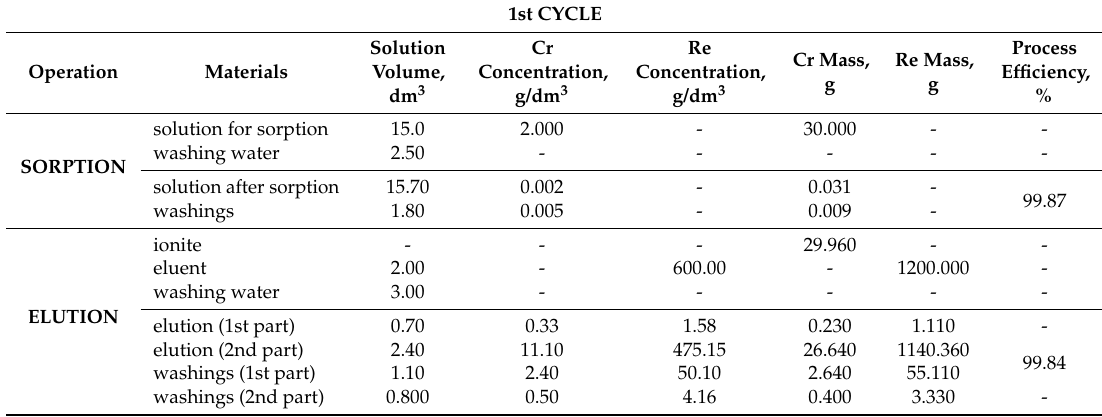
Table 1. Chromium(III) sorption and elution balance—1st cycle.